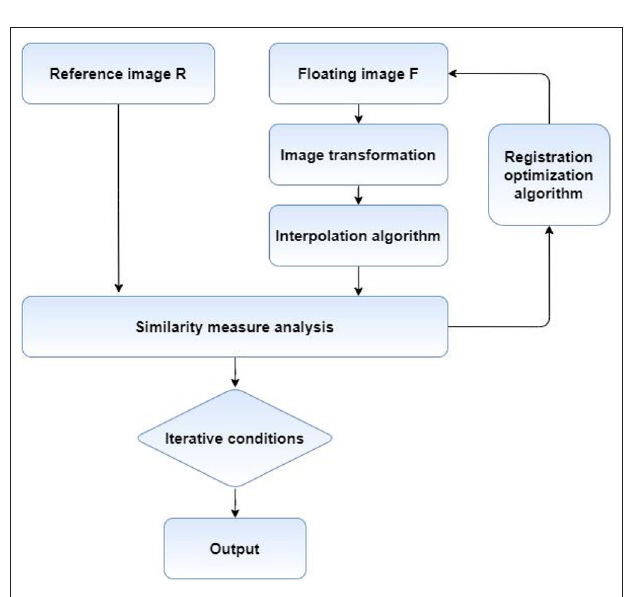
FIGURE 3 | The flowchart of PV image interpolation